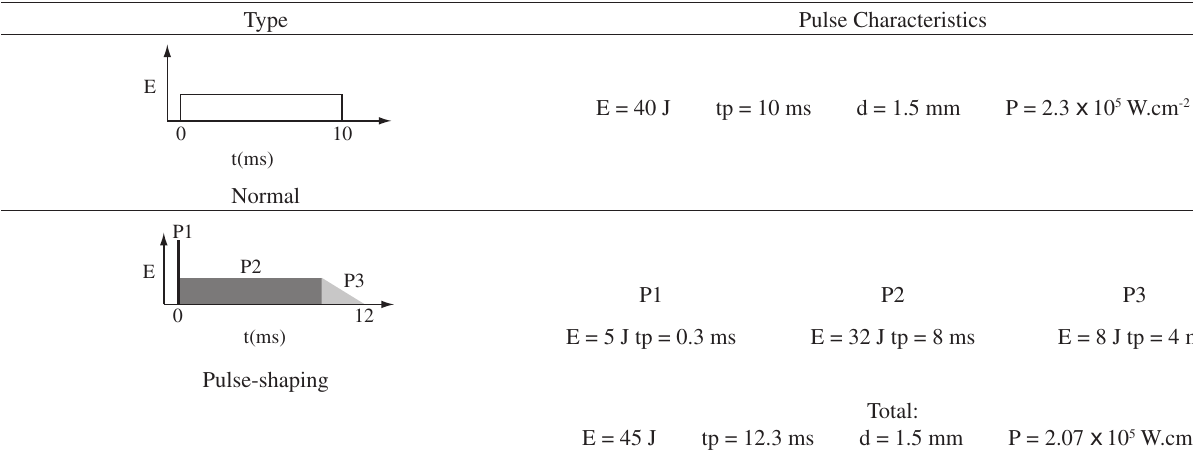
Table 1. Experimental